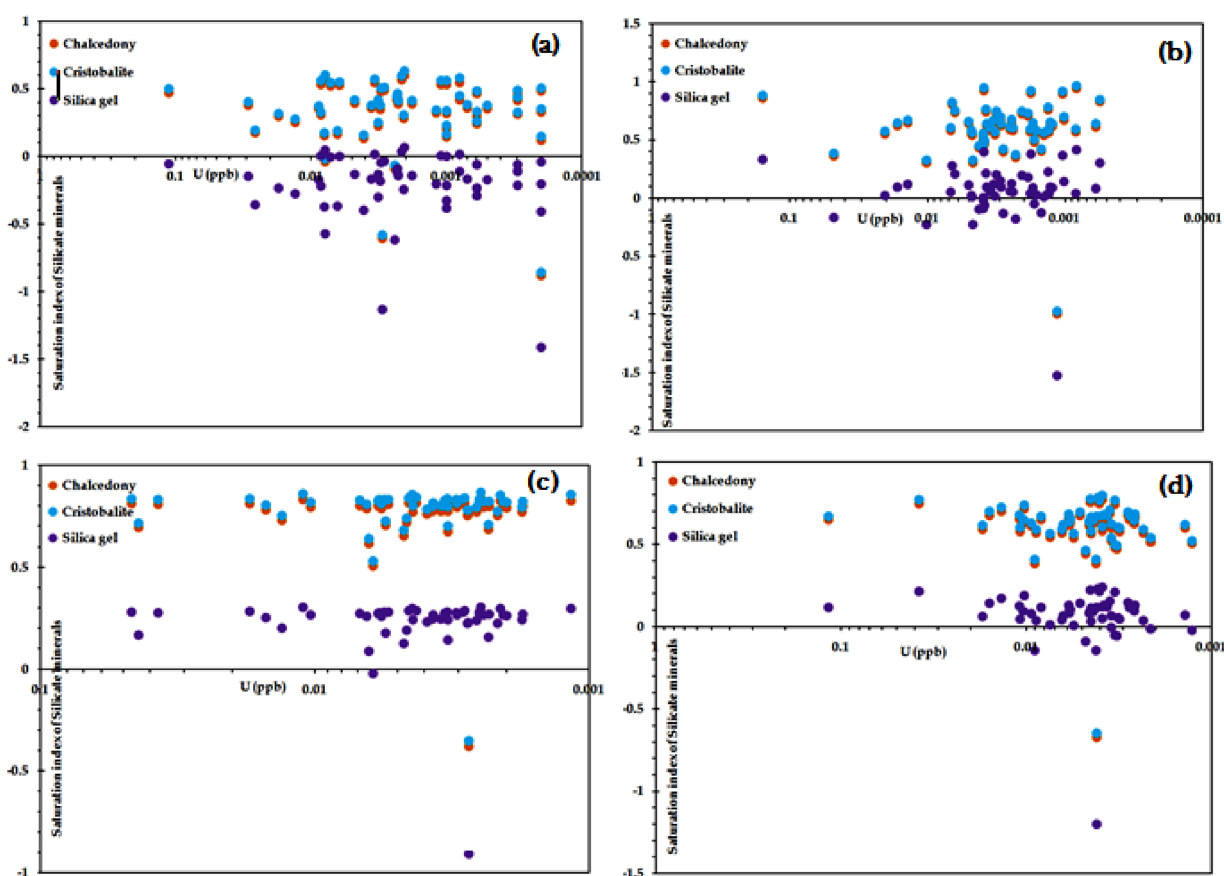
Fig. 16 Variation of Saturation index of different Silicate minerals with total uranium for samples collected during a PRM, b SWM, c NEM, d POM